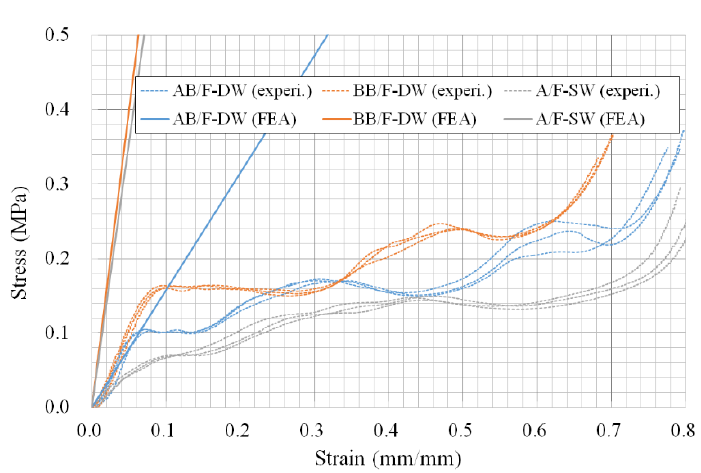
Figure 18. Comparison the stress-strain behavior (flat crush resistance) between the simplified FE model and experiment for target corrugated paperboards.